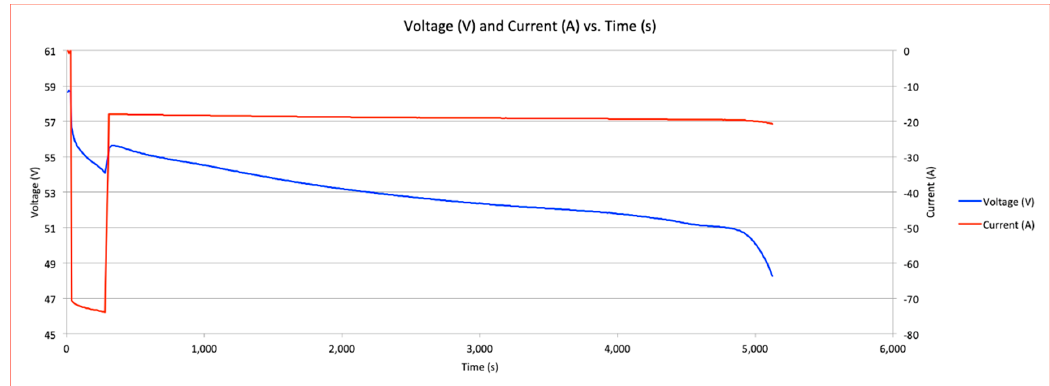
Figure 19. Battery pack test. Battery pack behavior under flight load profile.